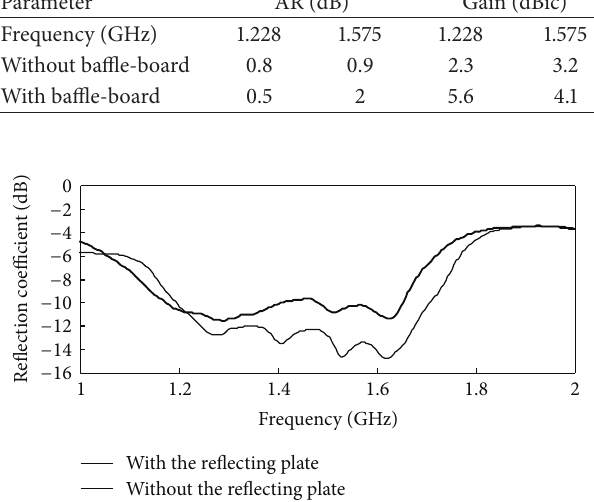
Figure 16: Comparison of measured results of reflection coefficient with and without the reflecting